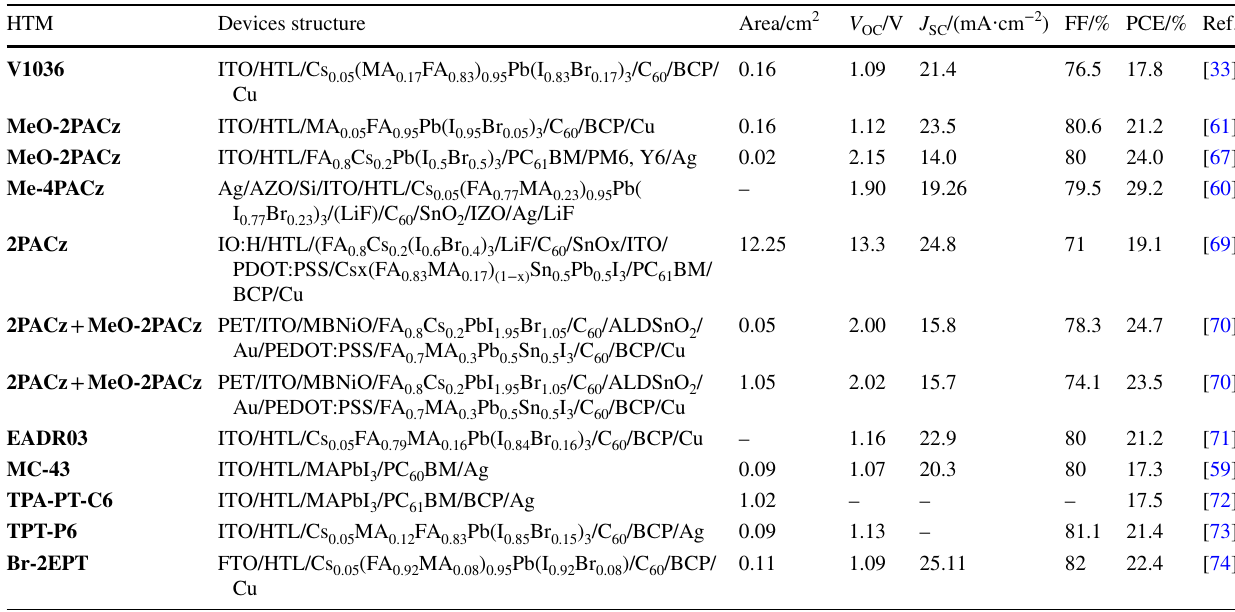
Table 2 Device structure and parameters of PVSCs based on distinct SAM-HTMs